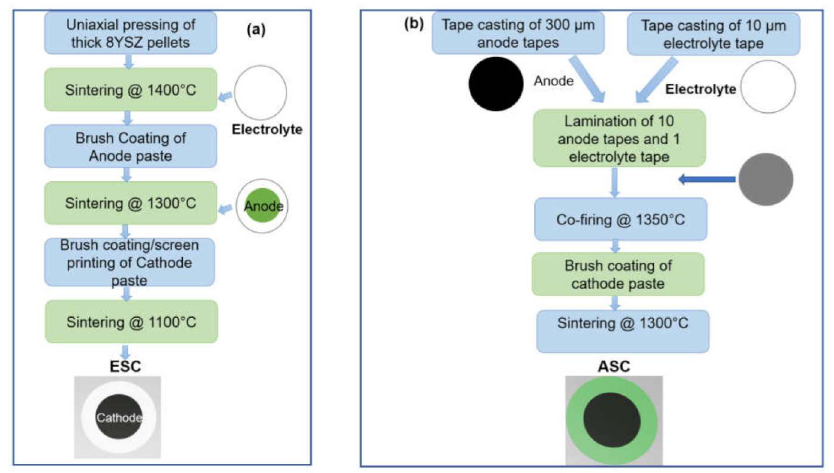
Figure 2. Flowchart depicting the steps involved in the fabrication of ( a ) ESC and ( b )